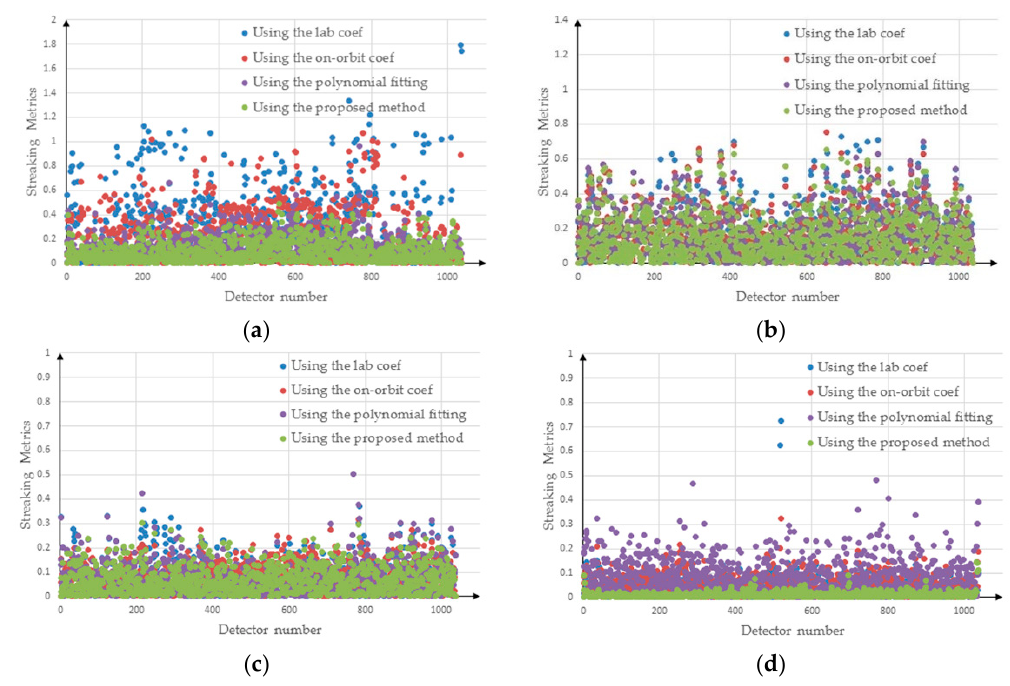
Figure 21. Streaking metrics for the corrected images: ( a ) water; ( b ) city; ( c ) hill; ( d ) desert.